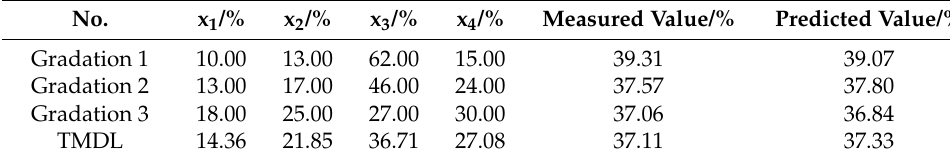
Figure 5. Gradation curves. Table 5. Predicted and measured VCA values of gradation curves.